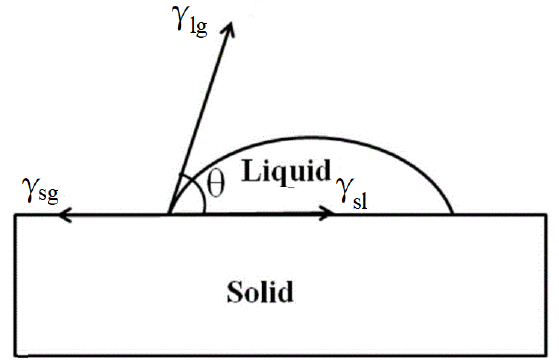
Figure 2. Schematic diagram of surface tension at the junction of contact angle and three